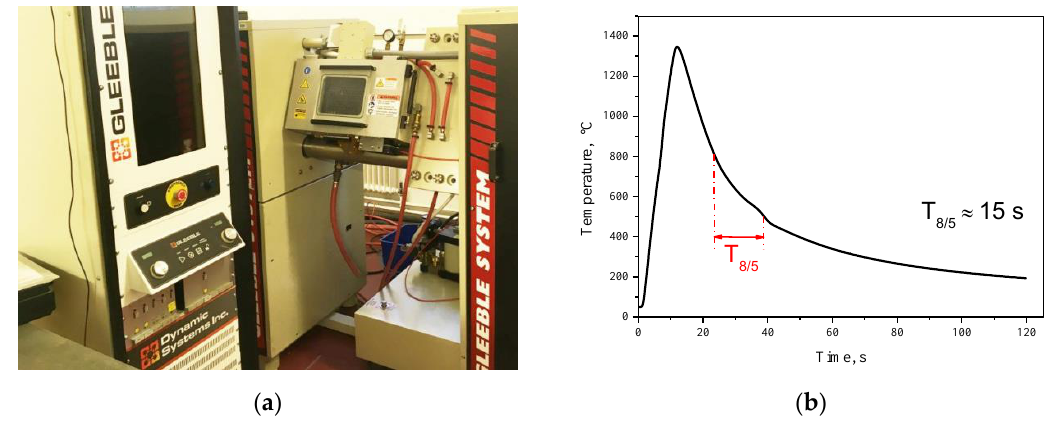
Figure 1. ( a ) Gleeble weld thermal simulator; ( b ) temperature vs. time history during the weld thermal simulation.